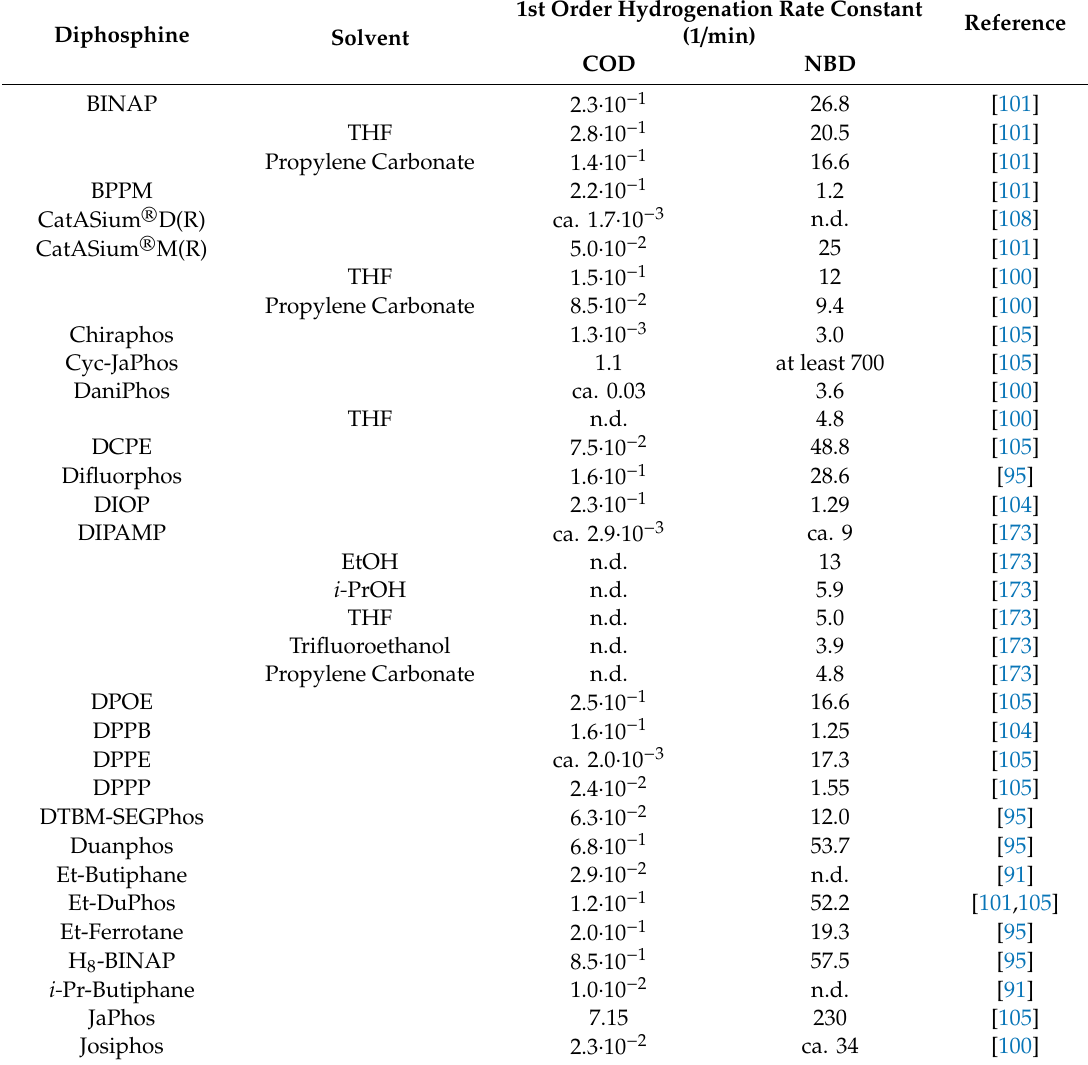
Table A1. Pseudo rate constants relative to diolefin hydrogenation for the hydrogenation of COD and NBD for di ff erent [Rh(diphosphine)(diolefin)] + complexes (25.0 ◦ C; 1.0 bar total pressure). The